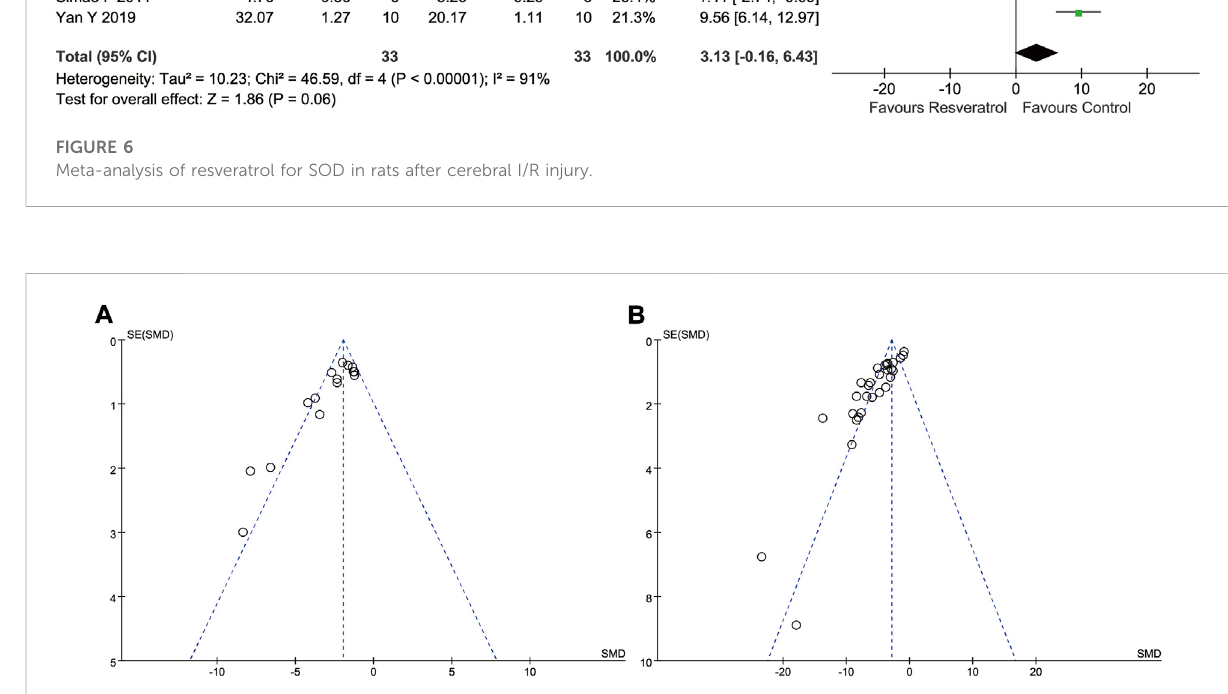
FIGURE 7 Funnel plots of publication bias for cerebral infarct volume (A) and neurological de fi cit scores (B)